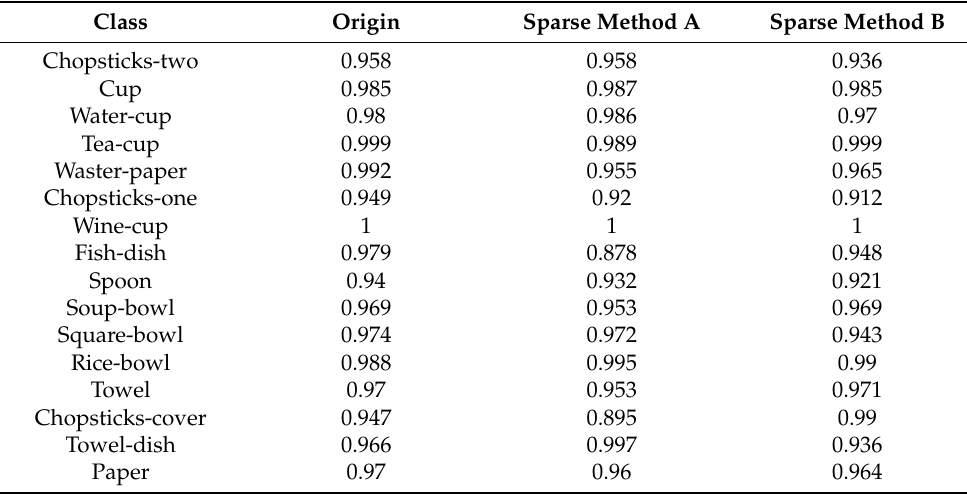
Table 2. Detection accuracy of model before pruning on FPGA.